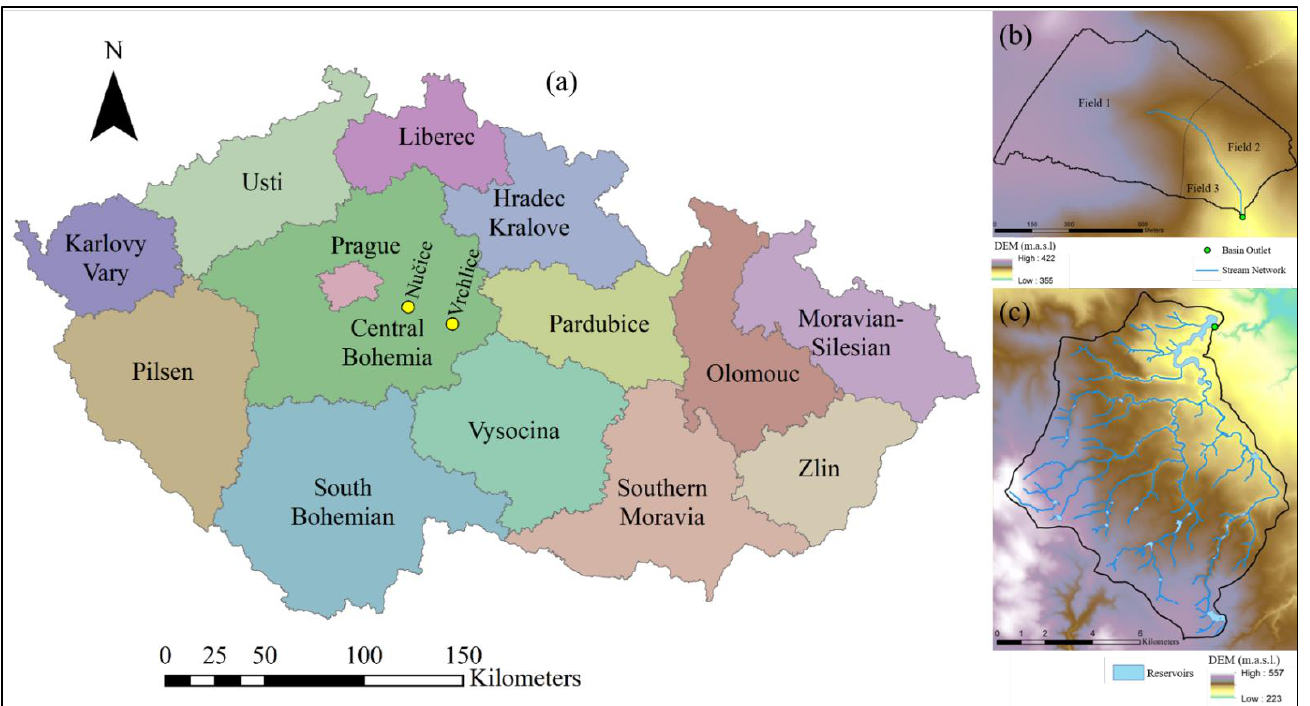
Figure 1. ( a ) A map of the Czech Republic. Prague is highlighted for reference as well as the outlet locations of the two study watersheds, Nučice ( b ) and Vrchlice ( c ).